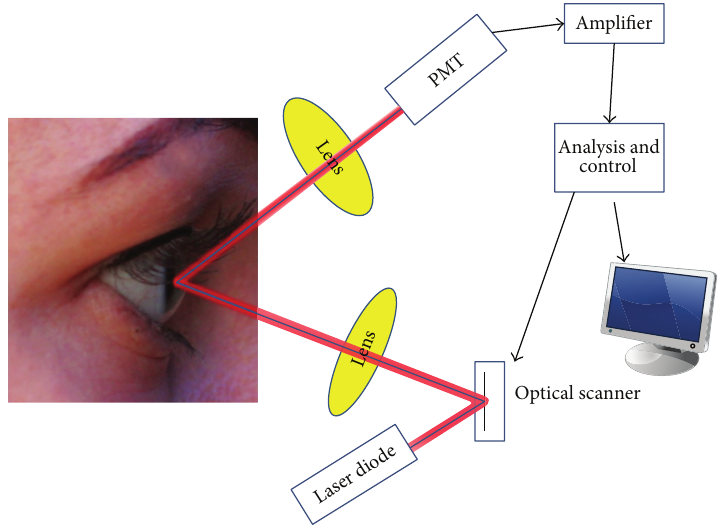
Figure 2: Measurement principle of laser flare photometry based on laser light scattering detection. A measurement window is projected inside the anterior chamber of the eye and is scanned by a diode laser beam. As an aqueous protein or another particle (i.e., component of inflammation) passes through the focal point of the laser, light scattering occurs. A photomultiplier-tube then detects the intensity of the scattered light, which is directly proportional to the amount of protein particles or flare, and generates an electrical signal. These signals are processed by a computer and immediately displayed for user analysis.